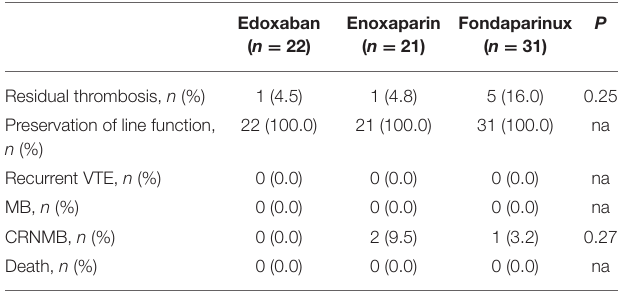
TABLE 2 | Comparison of effectiveness and safety between patients treated with edoxaban, enoxaparin, and fondaparinux. Edoxaban ( n =